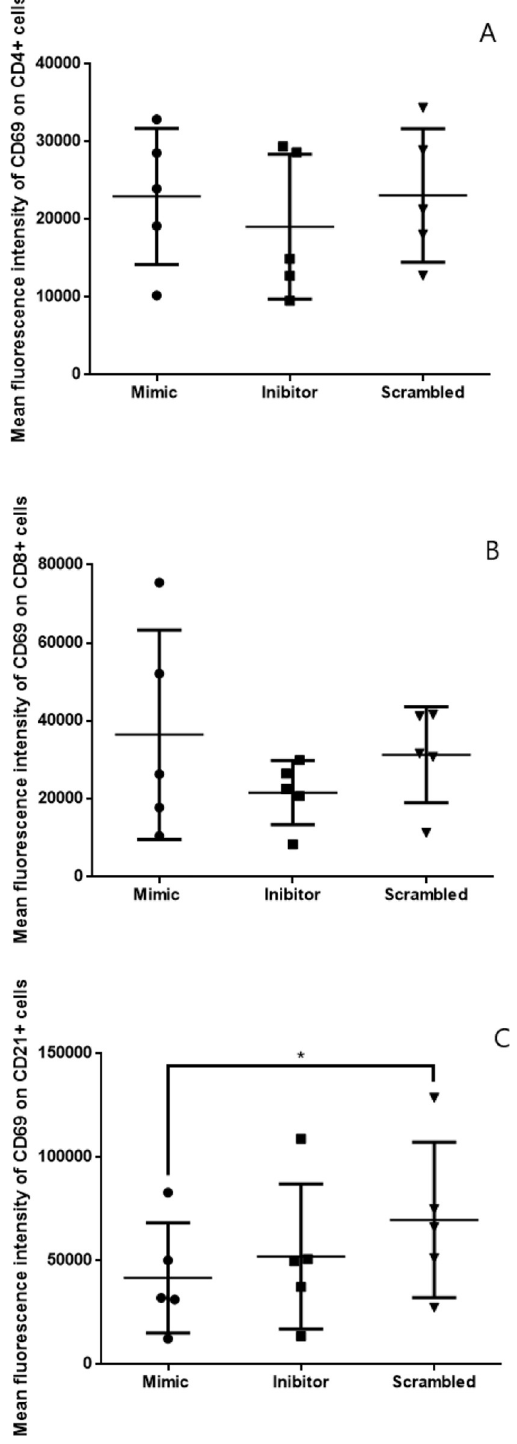
Fig 4. CD69 expression in T CD4+, T CD8+ and B lymphocytes. Expression of CD69 protein in (A) CD4+, (B) CD8 + and (C) B lymphocytes (CD21+ cells) in the CanL group. Splenic leukocytes of dogs naturally infected by L . infantum were transfected with scrambled, miR-21 mimic, and miR-21 inhibitor, all in the presence of Hiperfect, following 48 h in culture at 37˚C and 5% CO 2 . Data are presented as median ± min-max, and the asterisk indicates significant differences (Friedman’s multiple comparison test, � p <